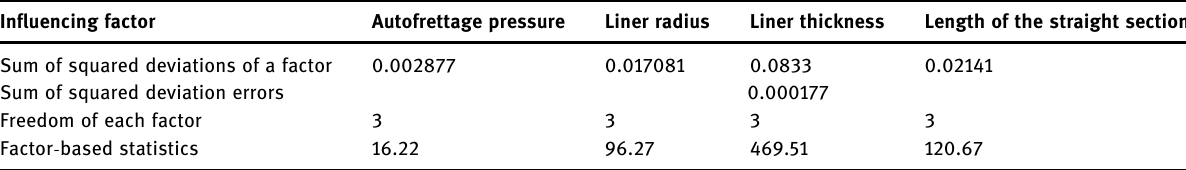
Table 5: Analysis of variance